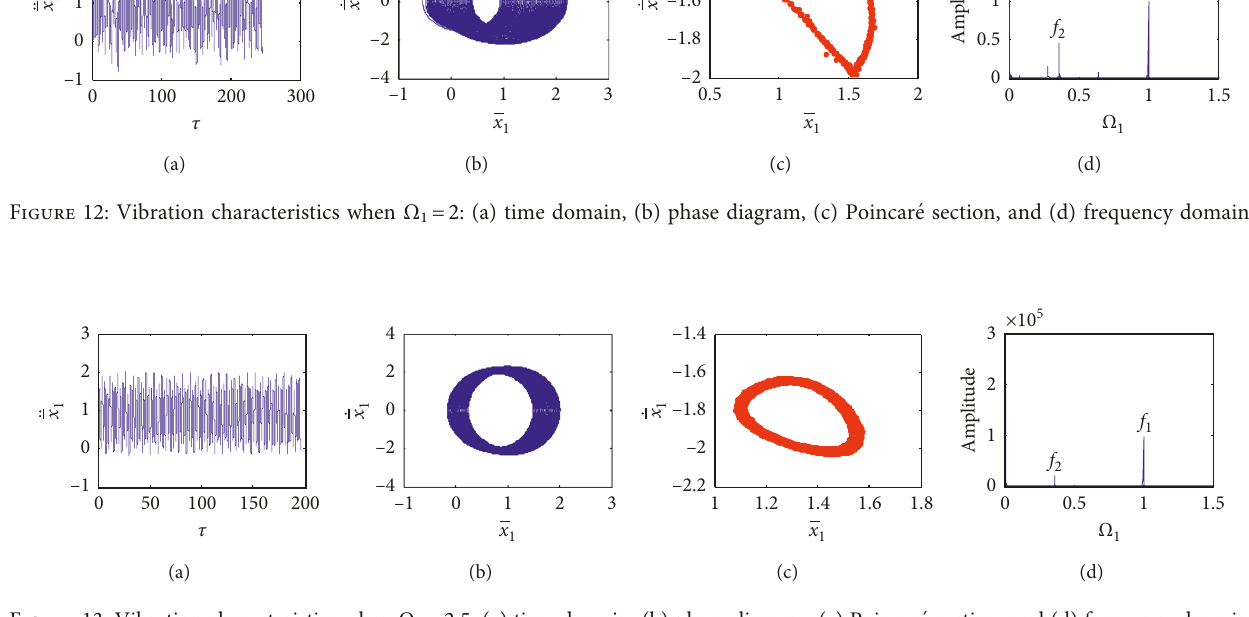
Figure 13: Vibration characteristics when Ω � 2.5: (a) time domain, (b) phase diagram, (c) Poincar´e section, and (d) frequency domain. 1